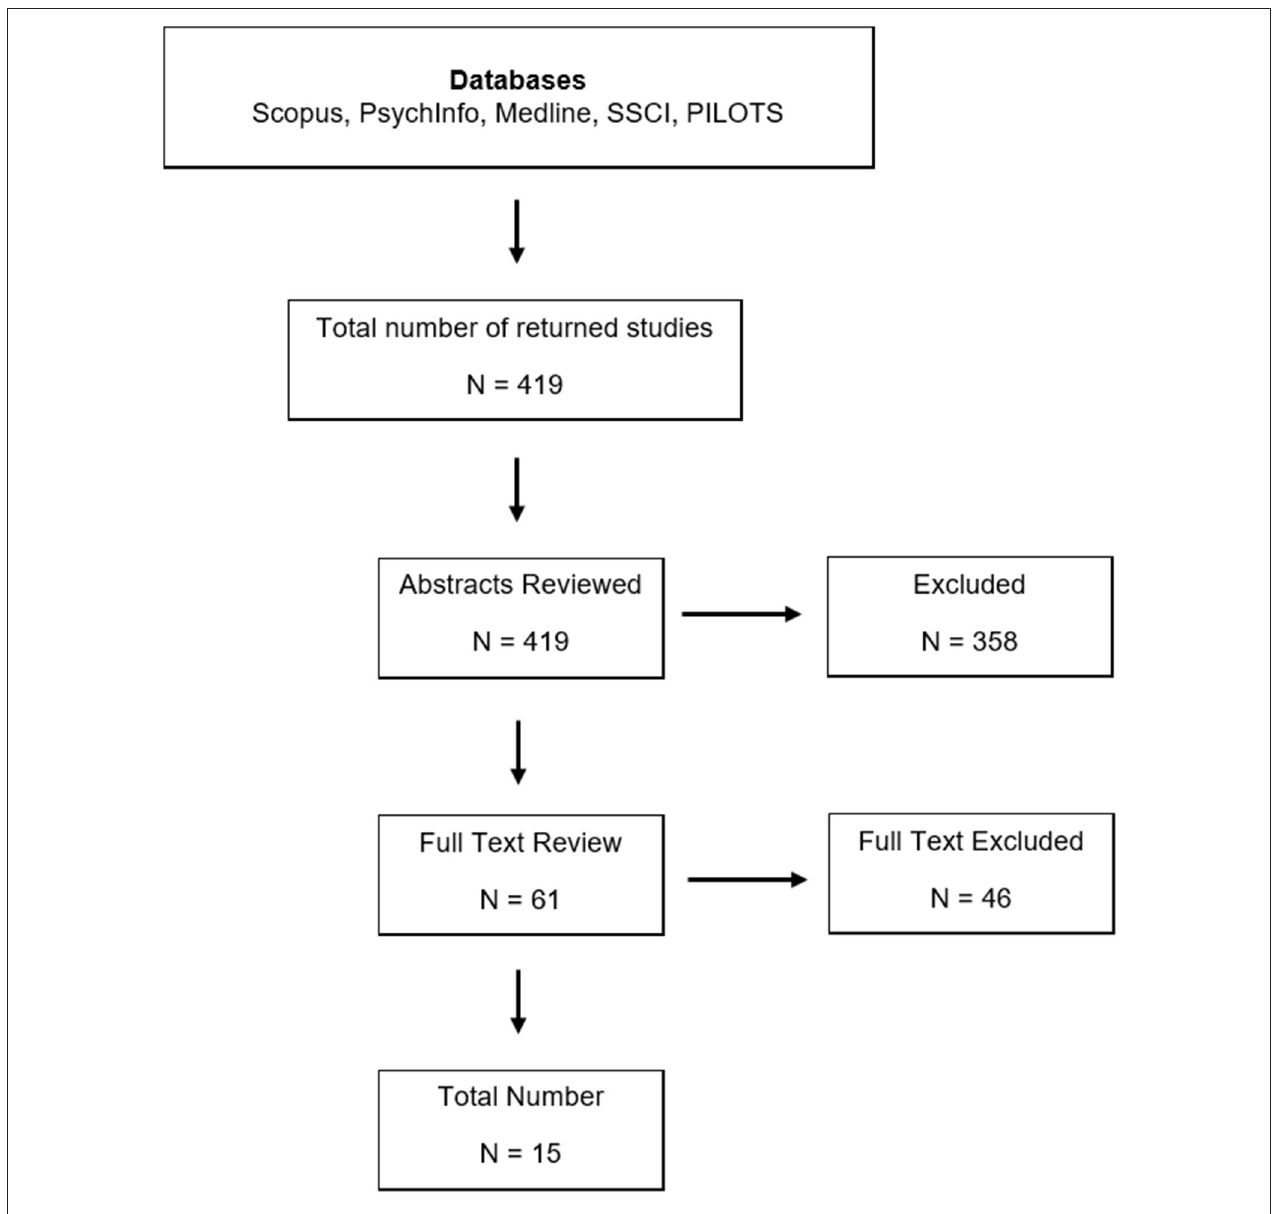
FIGURE 1 | Overview of search